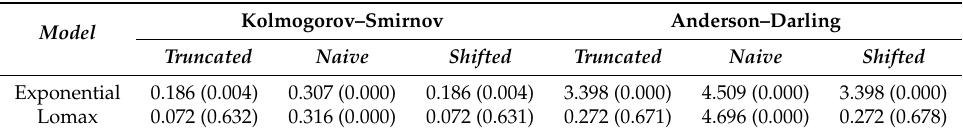
Table 5. Values of KS and AD statistics (with p -values in parentheses) for the fitted models, using truncated, naive, and shifted